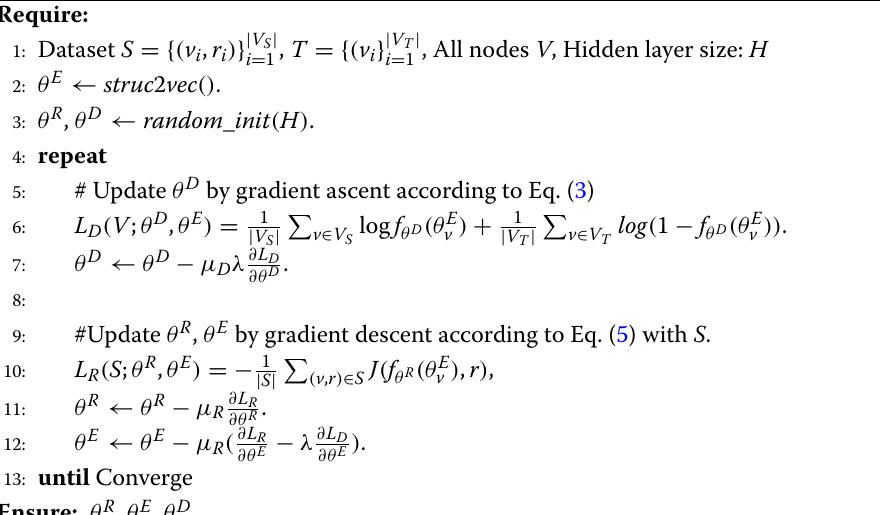
Algorithm 1 Domain Adversarial Learning for Role Discovery